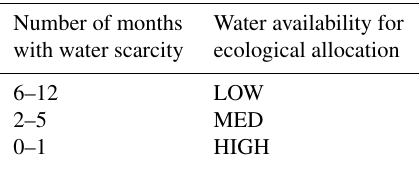
Table 3. Water availability for ecological allocations defined by means of the number of months with water scarcity upstream of the Ramsar site.